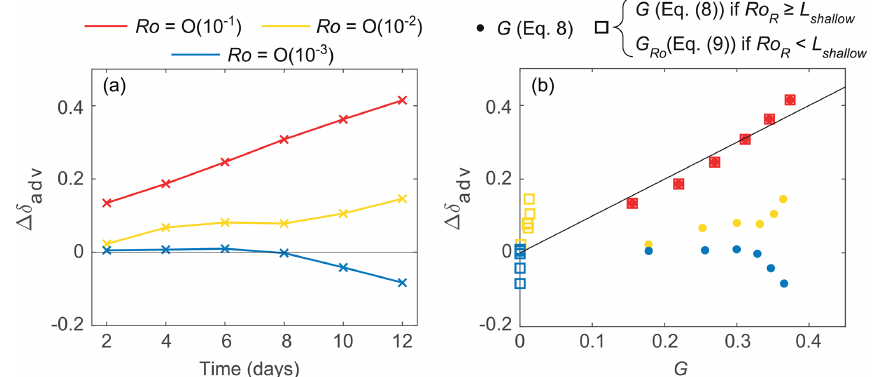
Figure 4. Contribution of advection to the total heat fluxes into the lake interior. (a) Time evolution of the simulated (cid:49)δ adv . (b) Simulated versus predicted contribution of advection based on the geometrical factors G (Eq. 8) and G Ro (Eq. 9). Each point in (a–b) represents the average value over the previous 2d. The black line in (b) shows the 1 : 1